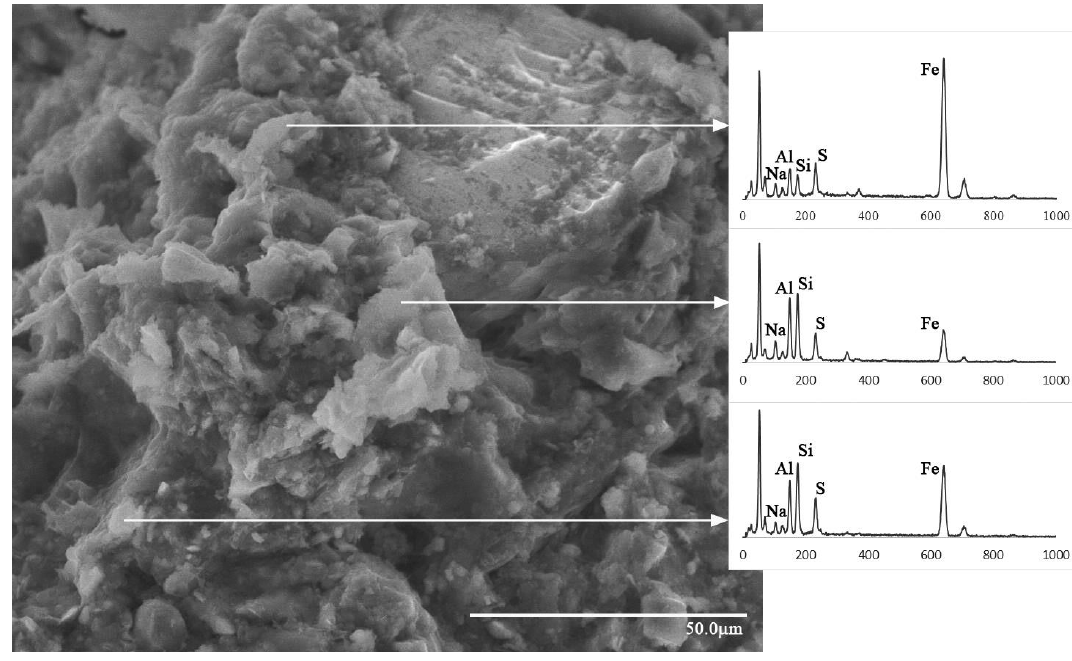
Figure 10. SEM micrographs and EDX analysis of paste P0. Table 5. Characterisation of the points presented in Figure